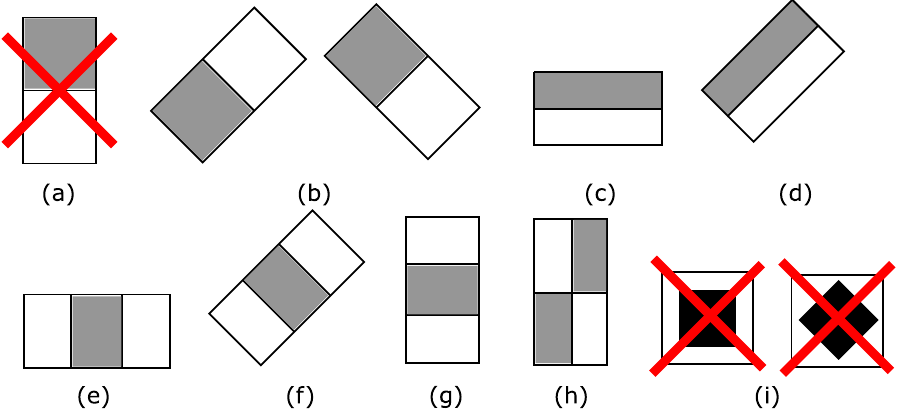
Figure 2. Prototypes of Haar-like features and their 45 ◦ rotated versions. ( a ) Vetical-double (not used). ( b ) Kernel in ( a ) rotated 45 ◦ . ( c ) Horizontal-double. ( d ) Kernel in ( c ) rotated 45 ◦ . ( e ) Horizontal 3 rectangle. ( f ) Kernel in ( e ) rotated 45 ◦ . ( g ) Vertical 3 rectangle. ( h ) Four rectangle. ( i ) Center-surround (not